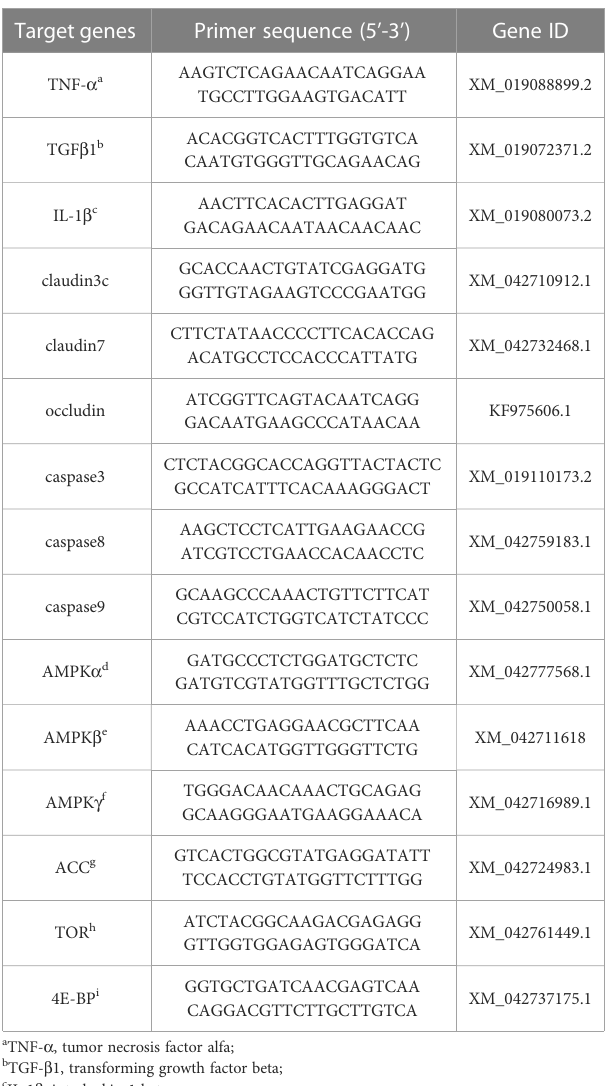
TABLE 2 Primer sequences of target genes from mirror carp ( Cyprinus carpio ), to measure the relative expression of the genes through quantitative real-time